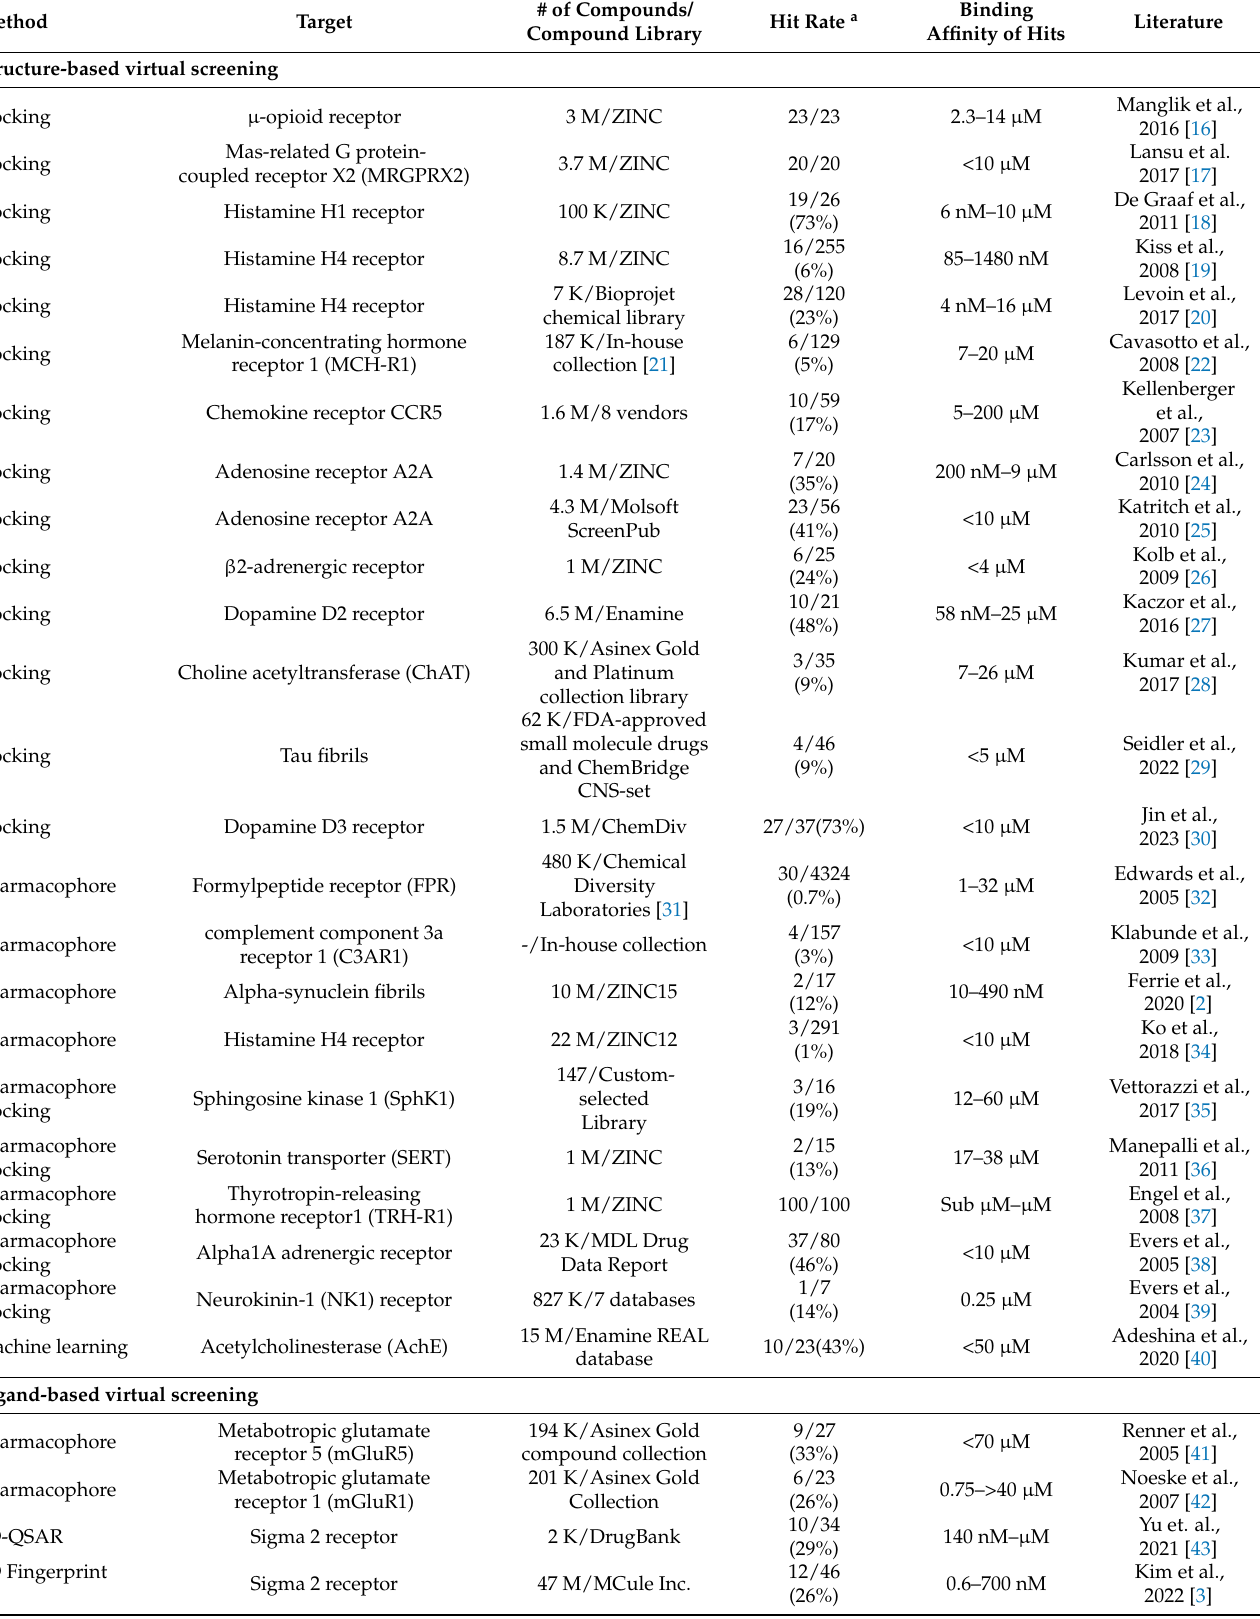
Table 1. Summary of the VS in the identification of small molecules for different protein